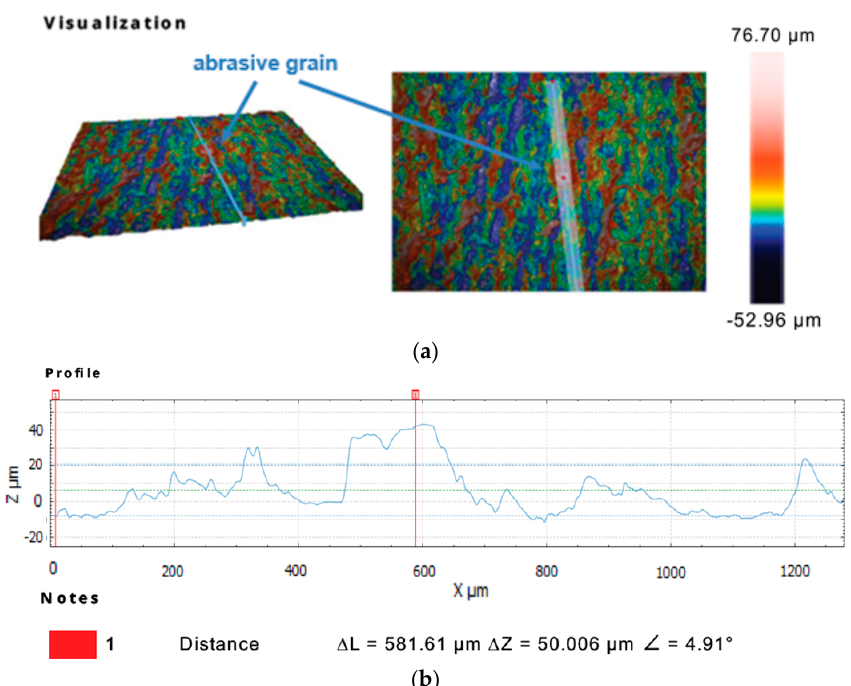
Figure 10. Profile extraction for a cross-section containing a diamond abrasive grain using interfer- ometric microscopy: a measurement area with the indicated place of an extracted profile ( a ) and the extracted profile ( b ).